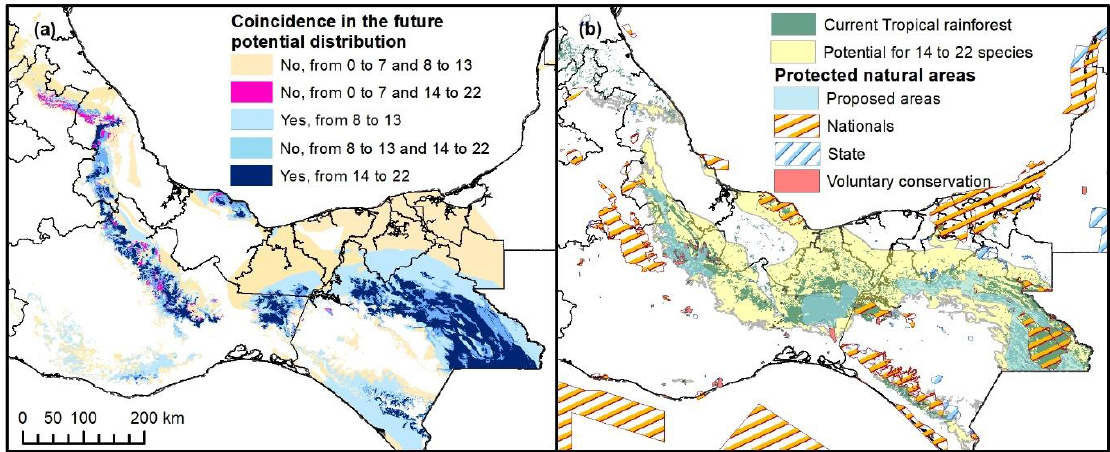
Figure 8. Proposed areas for Tropical Rainforest conservation in Mexico. ( a ) Coincidence in the future potential distribution by both climate change scenarios. ( b ) Proposed areas for conservation based on the coincidence of the future potential distribution of high species number (14 to 22) in both GFDL_CM3 and HADGEM_2 climate change scenarios.